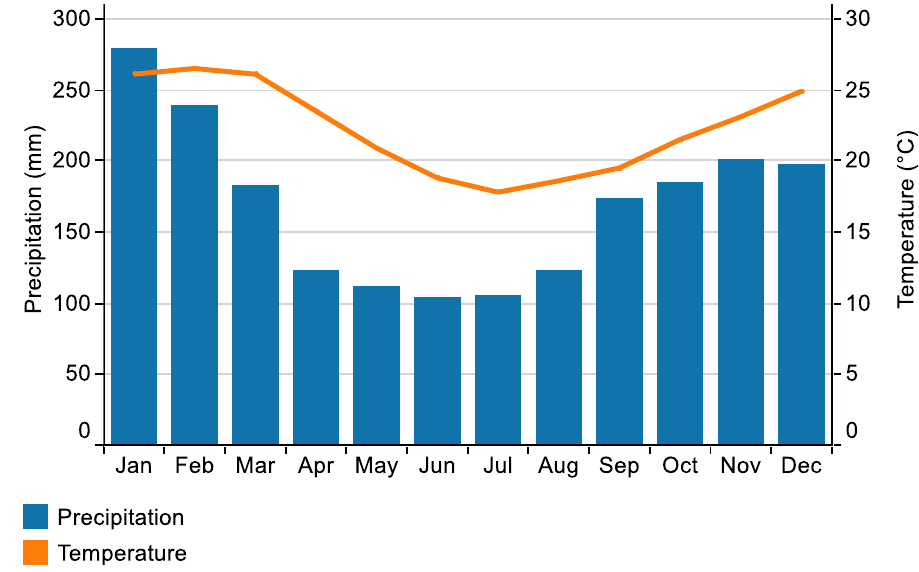
Figure 1. Average monthly precipitation and temperature in Joinville.